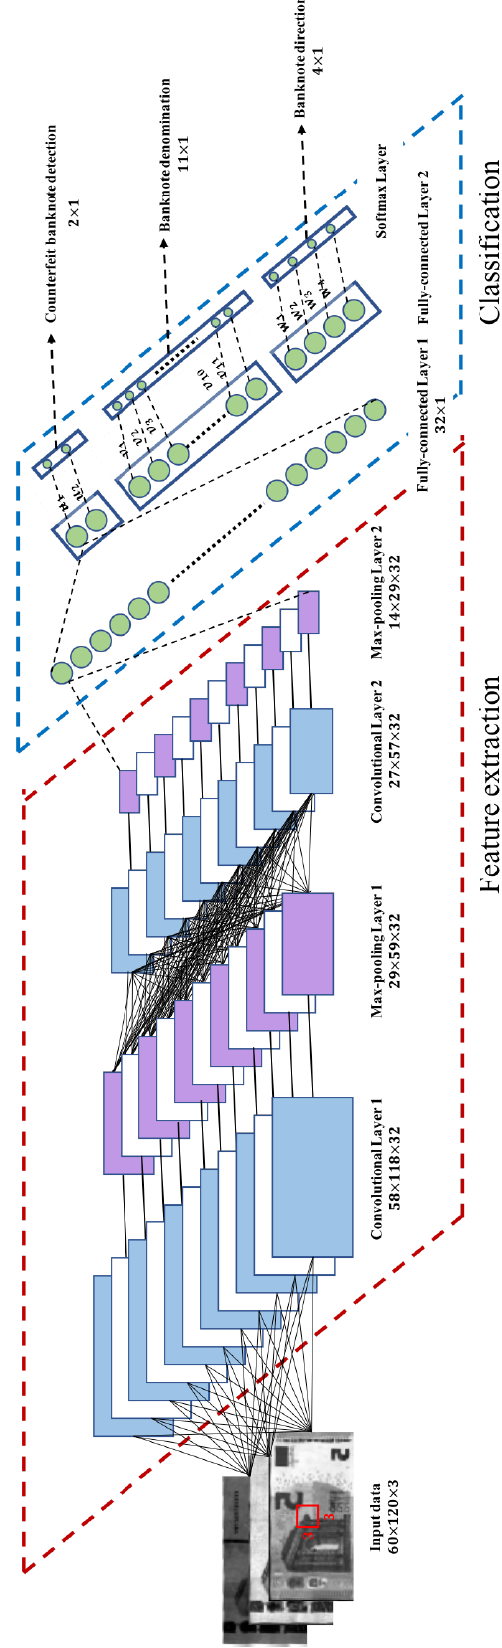
Figure 4. Joint banknote recognition and counterfeit detection